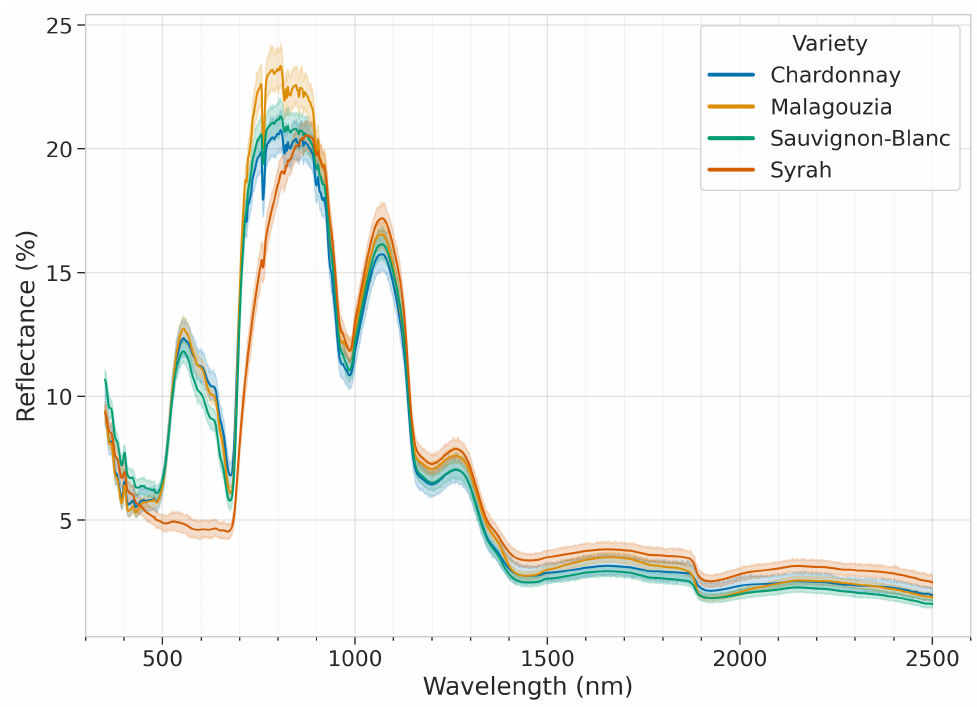
Figure 6. Mean spectrum (with confidence interval) of the reflectance spectra per each